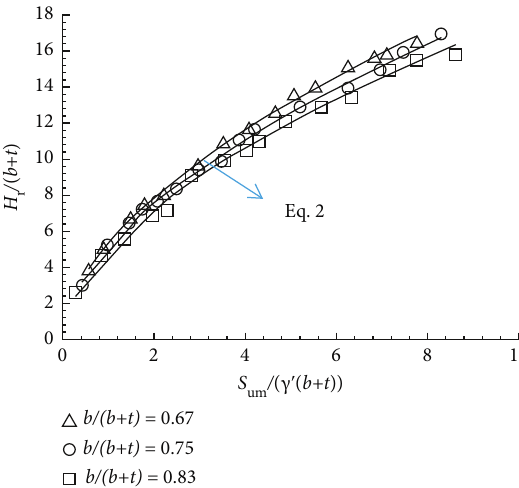
Figure 11: Design chart of the limiting cavity